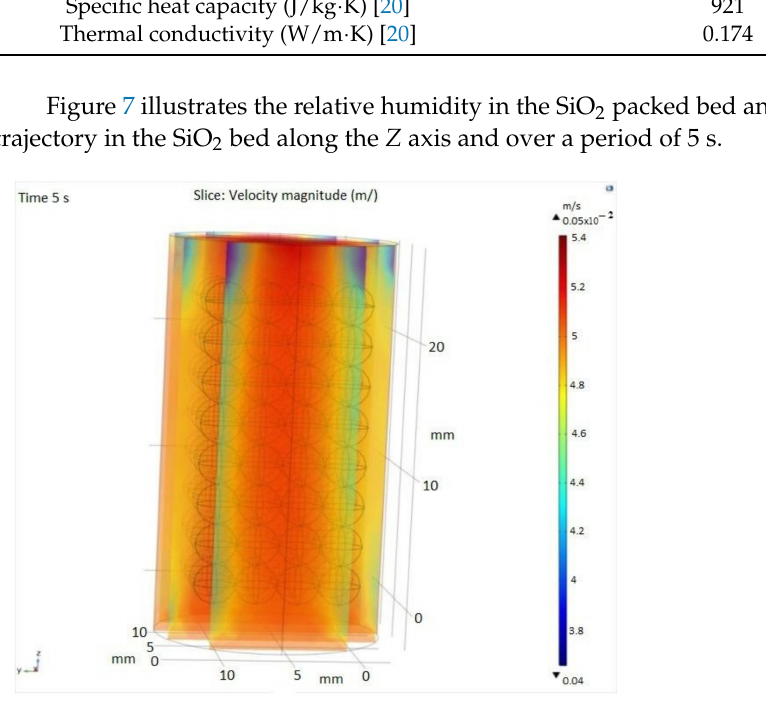
Figure 7. 3D velocity profile expressed in